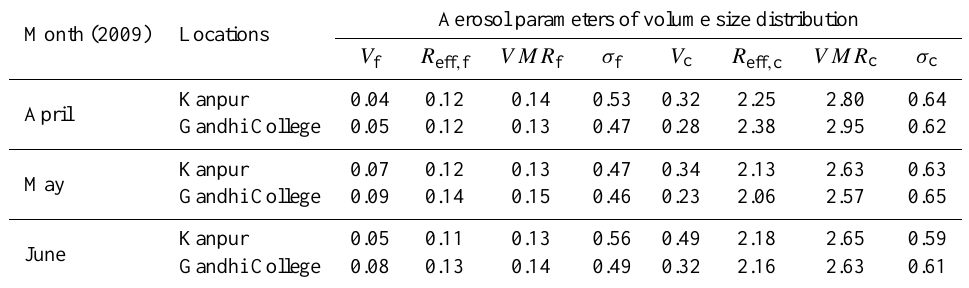
Table 2. Mean volume size distribution parameters of aerosol particles ∗ at different stations over IGB region during pre-monsoon. Aerosol parameters of volume size distribution Month (2009) Locations